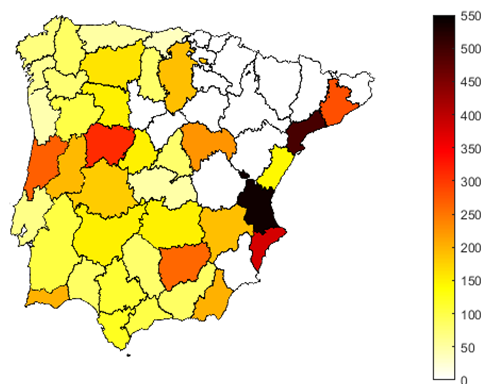
Figure 2. Representation of 95th percentile of burned area (ha) for each of the provinces of the Iberian Peninsula. Provinces with very few large fires are represented in white and were disregarded.